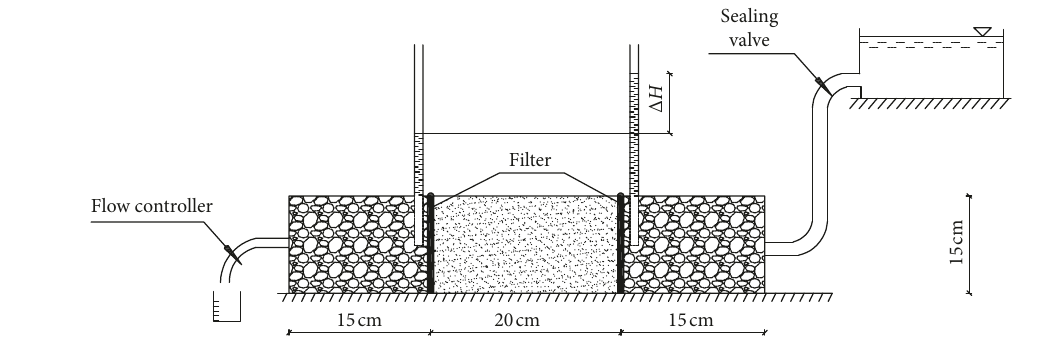
Figure 2: The facade schematic of experimental model.